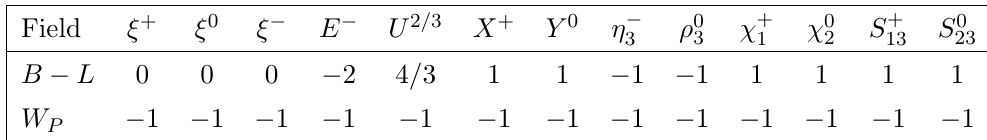
Table 2 . Nontrivial matter parity and B (cid:0) L